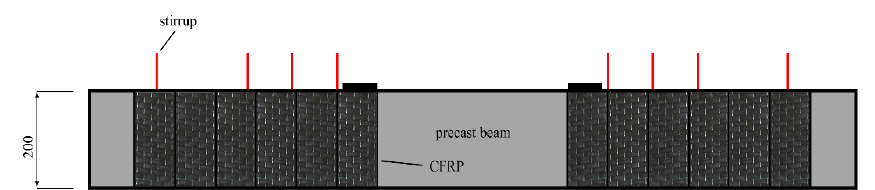
Figure 6. A schematic of the carbon fi ber reinforcement method (unit: